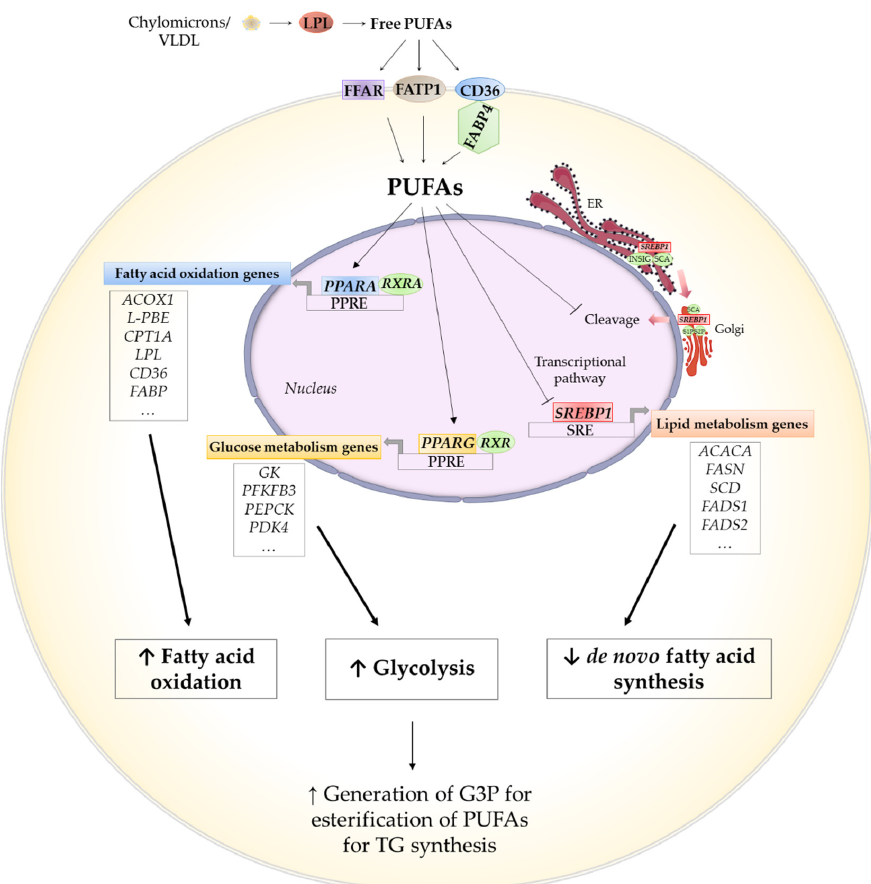
Figure 7. Diagram illustrating potential mechanism of gene regulation by polyunsaturated fatty acid (PUFA). Source: own elaboration. PUFA act as ligands for peroxisome proliferator–activated receptors ( PPAR ). Activation of PPAR alpha (PPARA) by PUFA promotes the transcription of enzymes involved fatty acid oxidation and fatty acid transport. Activation of PPARG is likely to increase glucose metabolism for generation of glycerol-3-phosphate (G3P) for esterification of long chain PUFA for triacylglyceride (TG) synthesis. PUFA inhibit the proteolytic processing and transcription of sterol regulatory element-binding protein ( SREBP ) 1 . Abbreviations: ACACA = acetyl - CoA carboxylase ; ACOX1 = acyl-CoA oxidase ; CD36 = fatty acid translocase ; CPT1A = carnitine palmitoyltransferase 1A ; FABP4 = fatty acid-binding protein 4 ; FADS1 = fatty acid desaturase 1; FADS2 = fatty acid desaturase 2; FASN = fatty acid synthase ; FATP1 = fatty acid transport protein ; FFAR = free fatty acid receptor ; GK = glucokinase ; L-PBE = peroxisomal enoyl-CoA hydratase ; LPL = lipoproteinlipase ; PDK4 = pyruvatedehydrogenasekinase4 ; PEPCK = phosphoenolpyruvatecarboxykinase ; PFKFB3 = 6-phosphofurcto-2-kinase / fructose-2,6-bisphosphatase 3; PPRE = peroxisome proliferator response element; RXRA = retinoid X receptor alpha ; SCD = stearoyl-CoA desaturase ; SRE = sterol regulatory element; VLDL = very low density